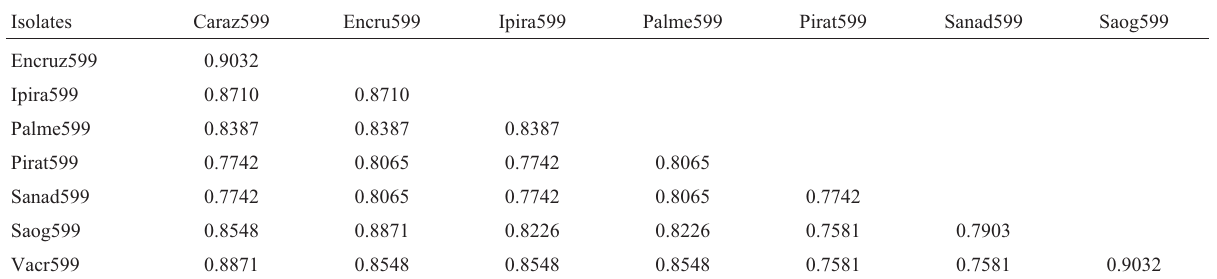
Table V - Drechslera teres similarity matrix coefficients based on random amplified polymorphic DNA (RAPD)